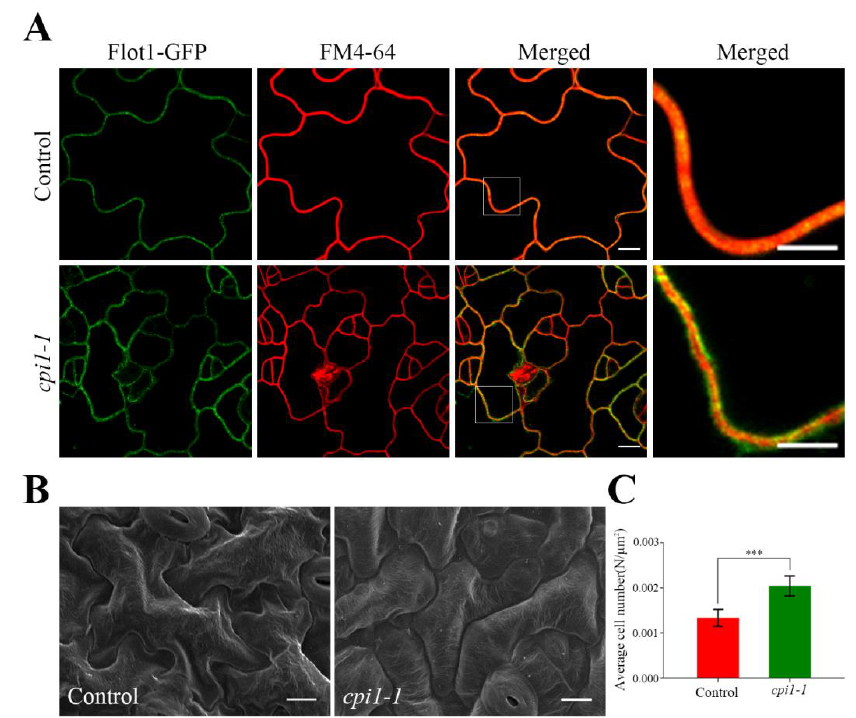
Figure 2. Characterization of the cotyledon epidermal cells in Flot1-GFP transgenic mutants. ( A ) The shape of a typical cotyledon epidermal cell in cpi1-1 mutants and wild-type transgenic Arabidopsis thaliana . Scale bar, 10 µ m. Localization of Flot1-GFP on the membrane of leaf epidermis cells. Scale bar, 5 µ m. ( B ) Scanning electron microscopy images of cpi1-1 mutants and control seedling cotyledon epidermal cells. Scale bar, 10 µ m. ( C ) Average number of cotyledon epidermal cells of leaves. Data shown are from 24 to 30 plants. Error bars represent the SD ( n = 3). *** p < 0.001, Student’s t -test.